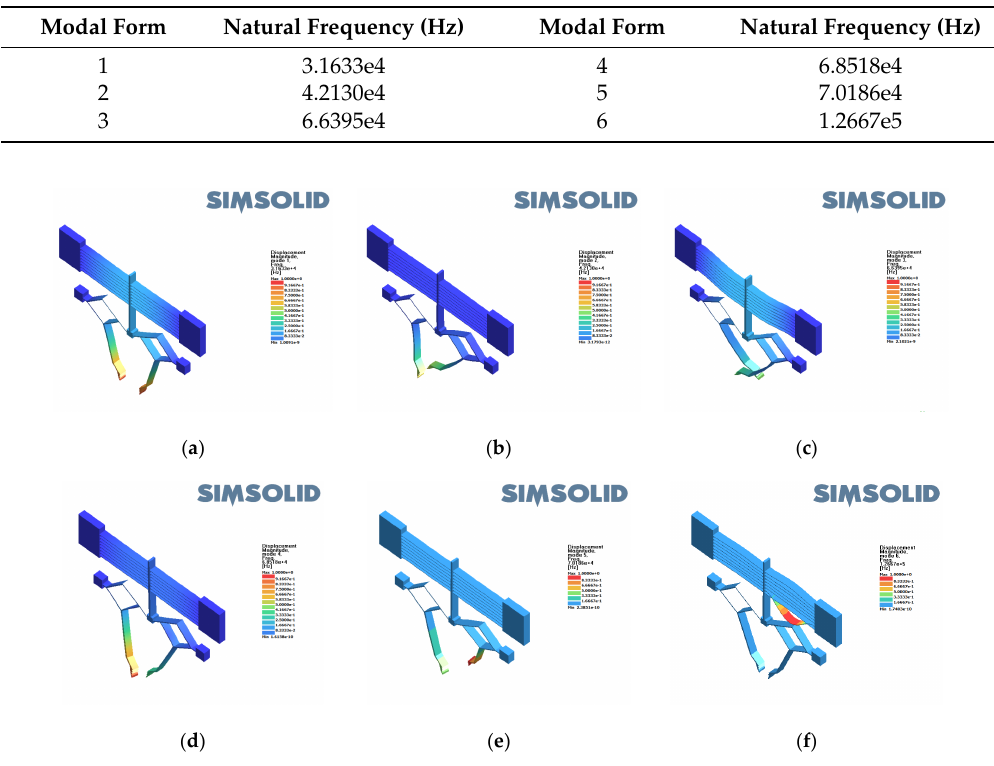
Table 10. Natural frequencies of modal forms.